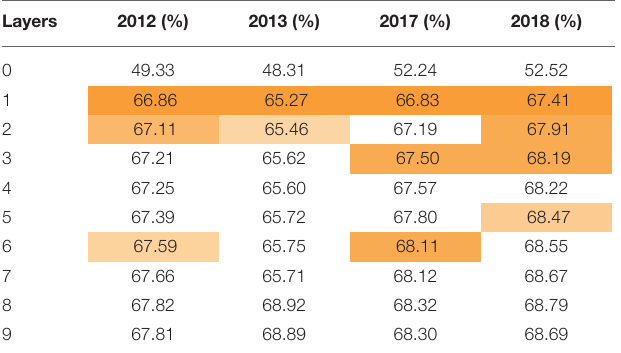
Darker shades represent lower p-values, e.g. a stronger statistical significance.